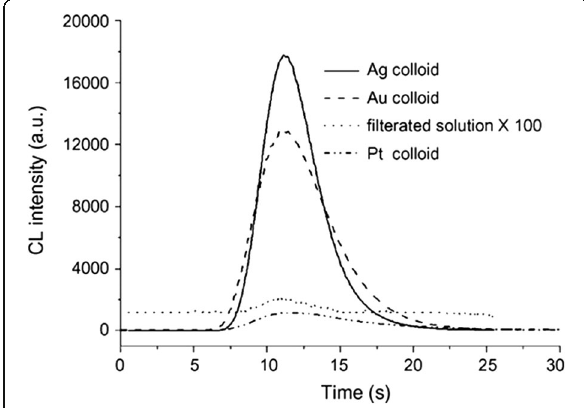
Fig. 17 Effect of Ag colloid (solid line), 38 nm Au colloid (dashed line), Pt colloid (dash-dot-dot line), and filtrated solution of precipitated Ag colloid (dotted line) on luminol – H 2 O 2 CL. The blank (filtrated solution of precipitated Ag colloid) signal was amplified by 100 times. Conditions: luminol, 1 × 10 – 4 mol/L; H 2 O 2 , 0.15 mol/L; pH 9.32 carbonate buffer for Ag, pH 12.0 NaOH for Au, pH